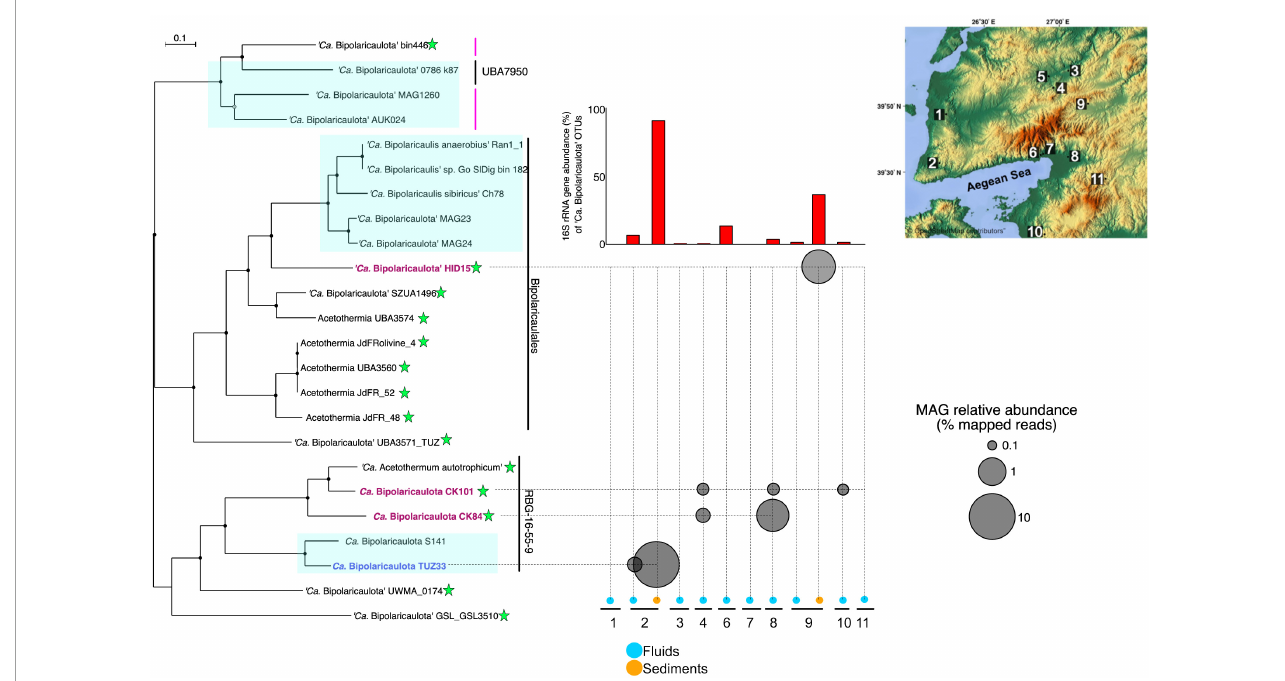
FIGURE4 The phylogenetic tree is an analysis of concatenated 69 ribosomal proteins extracted from 23 metagenome assembled genomes affiliated to ‘ Ca. Bipolaricaulota’. Black circles at nodes represent bootstrap support of 90%, gray circles represent bootstrap support from 70 to 90%, and white circles represent bootstrap support from 70 to 50%. Blue boxes represent the MAGs with no Wood-Ljungdahl pathway (WLP) encoded. The green stars show the MAGs containing the WLP. Bold and colored fonts represent the MAGs assembled from the geothermal sites in this study (dark blue and red). The bubble plot shows the relative abundance of the “ Ca. Bipolaricaulota” MAGs assembled in this study corresponding to their position in the phylogenetic tree. The histograms above the bubble plot show the relative abundance of ‘ Ca. Bipolaricaulota’ from 16S rRNA gene datasets for each sampling location. The map represents the sampling locations, which are also shown in Figure 1 and Supplementary Figure 1